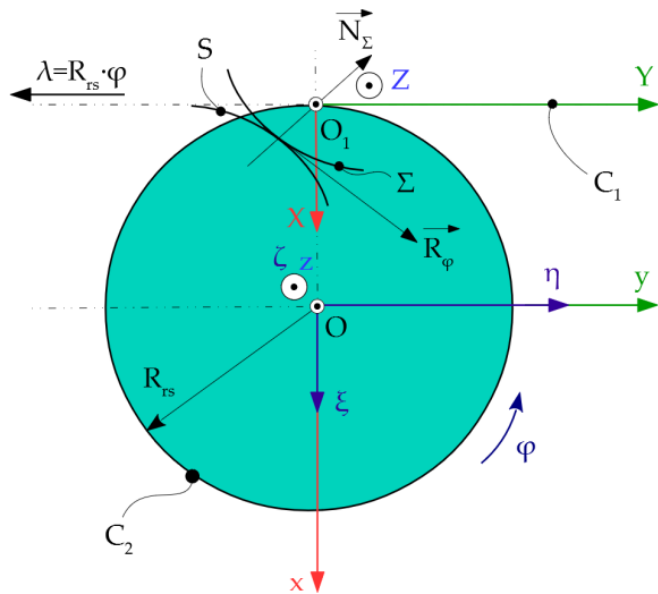
Figure 9. Generating with rotary cutter tool.